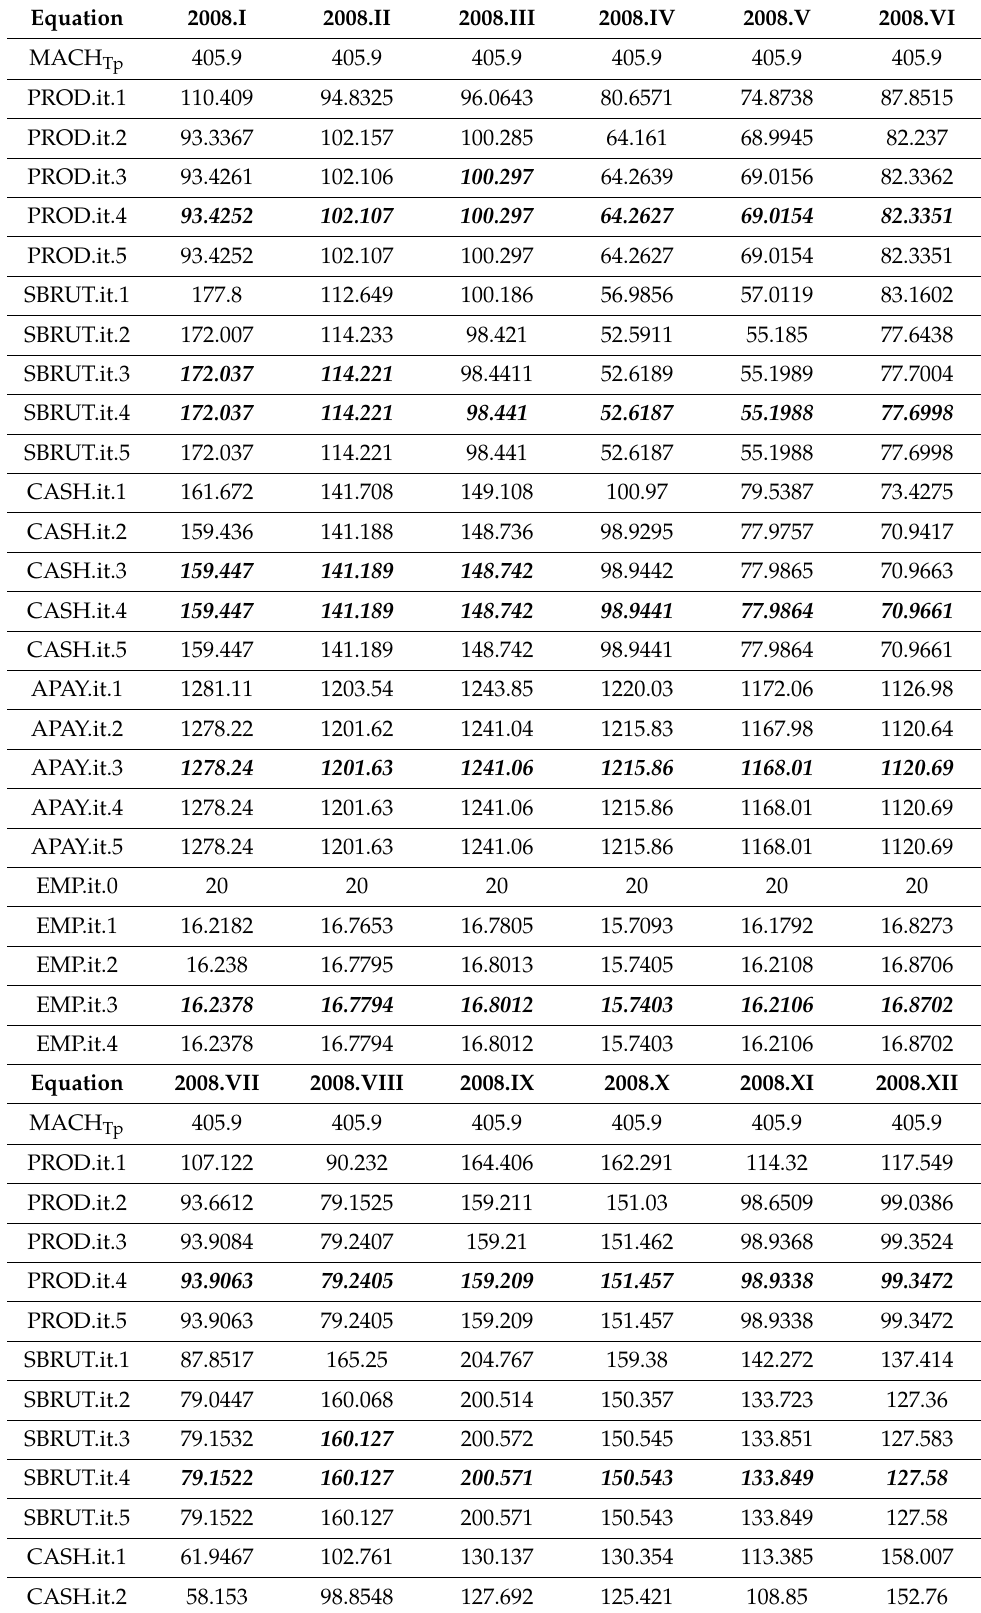
Table 1. Forecasts from the structural-form system of interdependent equations—the path to conver- gent forecasts, under the conditions of the stabilized initial value of machinery and equipment.